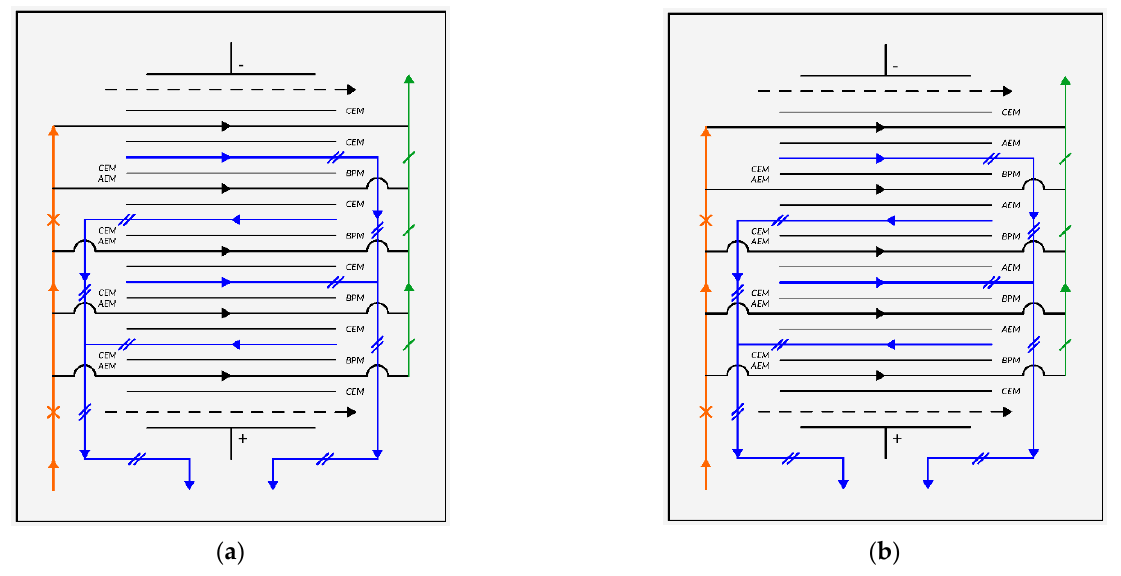
Figure 3. Schematic diagram of the electrodialysis process for the correction of acidic ( a ) and alkaline ( b ) solutions: AEM- anion, CEM-cation, and bipolar membrane (BPM); ----x---- initial solution, ---/-- product and ---//--- concentrate.